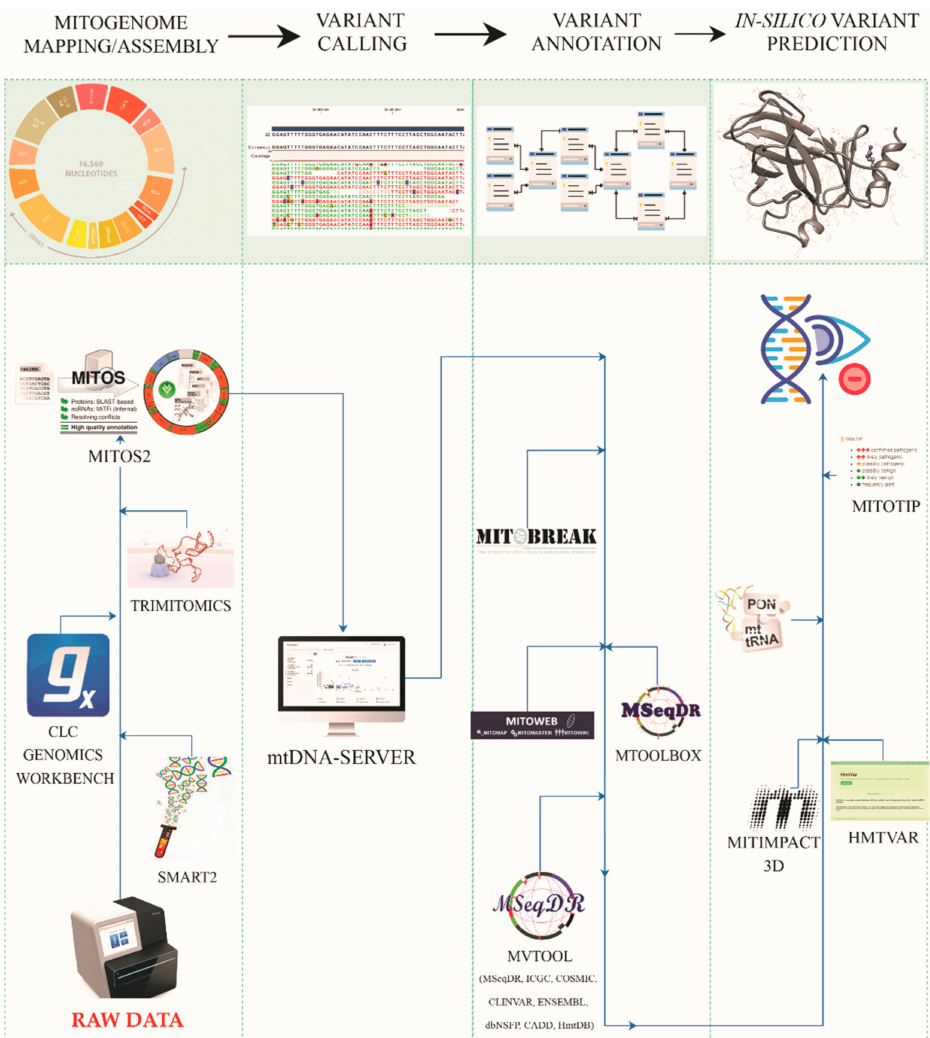
Figure 1. Proposed pipeline of mtDNA variant analysis. Figure shows applied workflow of mtDNA variant analysis, highlighting the single macro-steps with specific tools and explored